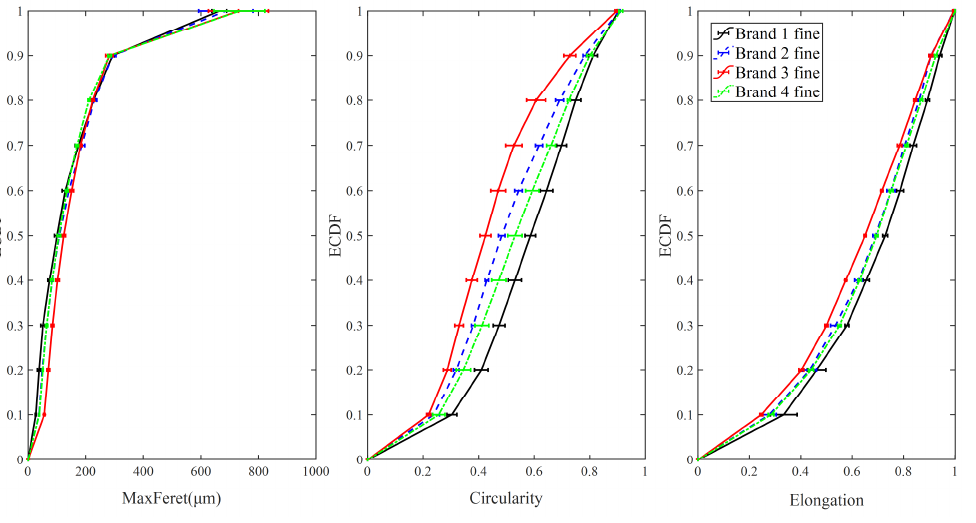
Figure 4. The empirical cumulative distribution function (ECDF) of shape factors for fine particles.